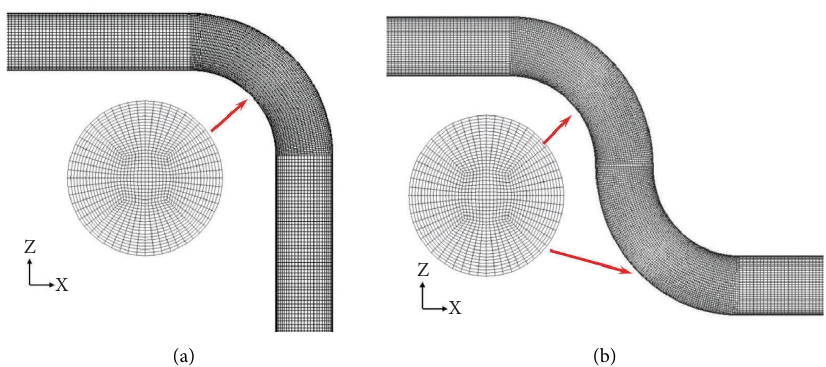
Figure 2: Schematic diagrams of calculation domain meshing. (a) L-shaped pipe, (b) Z-shaped